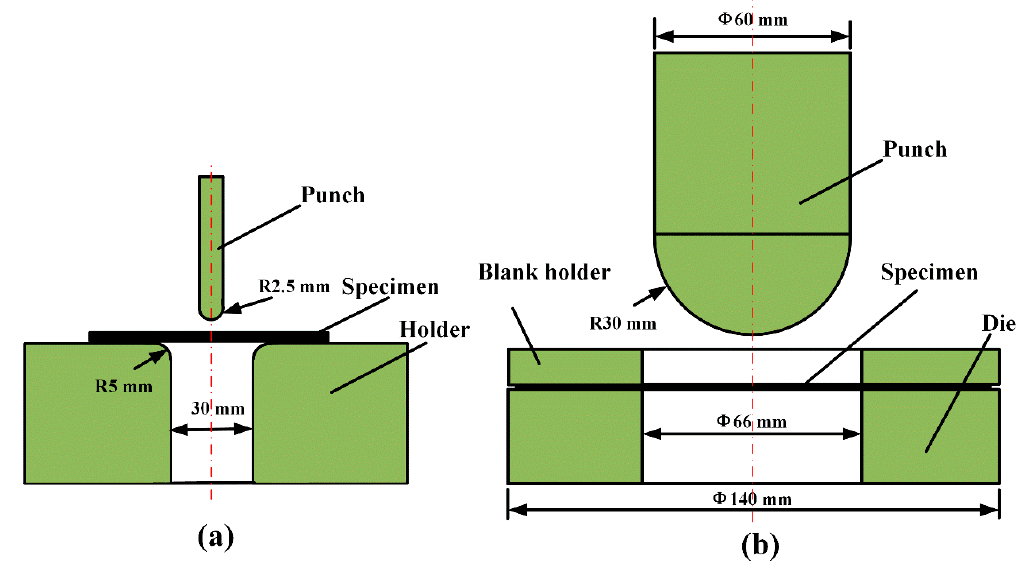
Figure 3. Schematic diagram of flexural and Erichsen tests at elevated temperature: ( a ) Flexural test; and ( b ) Erichsen test.